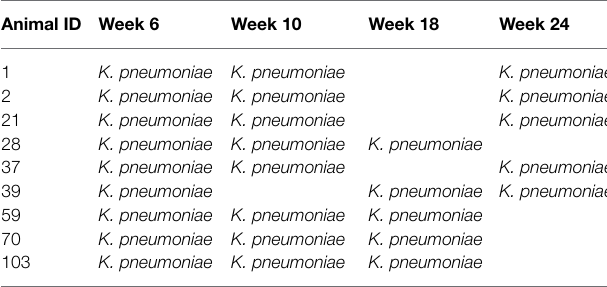
TABLE 1 | Distribution of fecal carriage of ESBL- Klebsiella pneumoniae isolates per time point (week 6 until week 24 after arrival of calves at a Dutch veal farm) selected for MLST